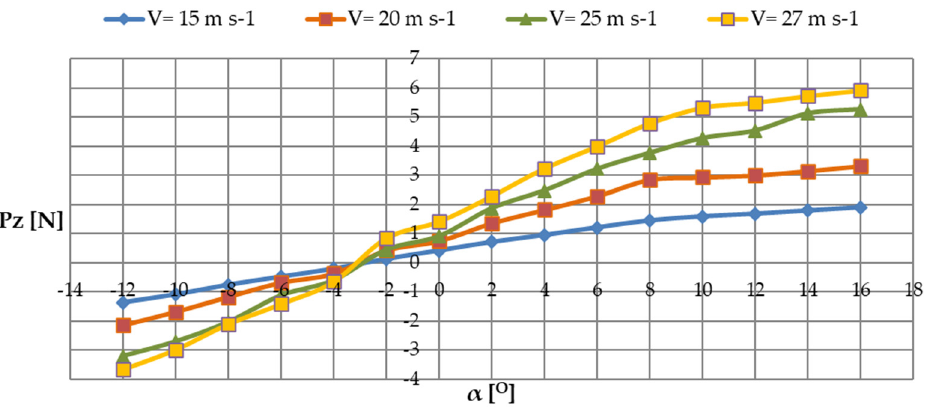
Figure 10. Summary plot of lift force, Pz, for positive and negative angles of attack, α , for all airflow speeds tested.